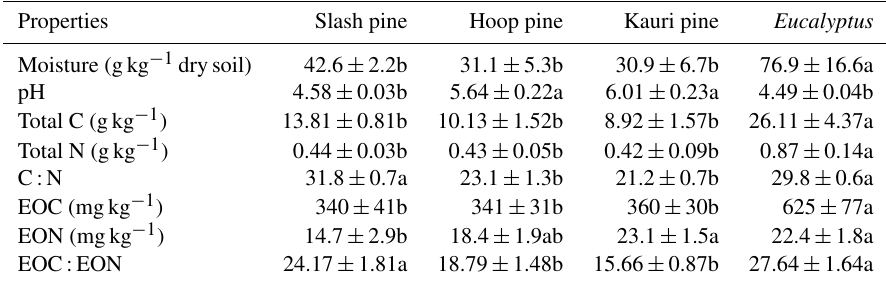
Table 1. Soil physiochemical properties in 78-year-old forest plantations with different tree species. Properties Slash pine Hoop